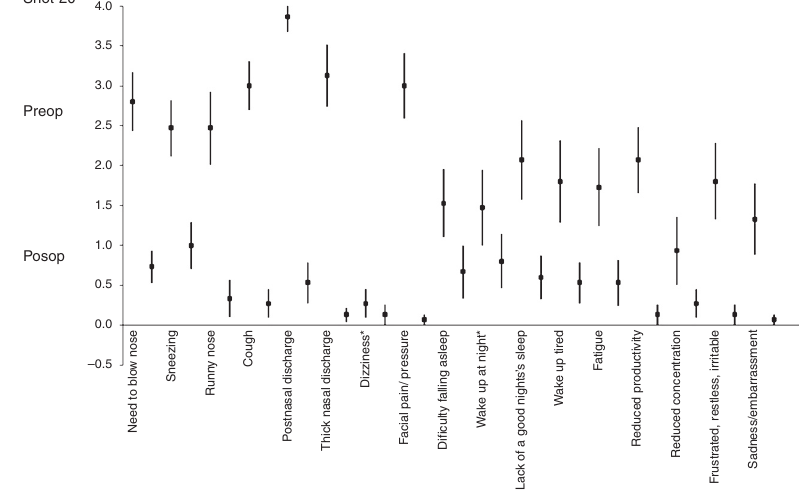
Change in clinical signs of the Sino-Nasal Outcome Questionnaire Test-20 [SNOT-20] from pre- to post-operative period. For all clinical signs, the change from pre- to postoperative had p -value ≤ 0.01, except for those marked with * ( ≥ 0.2). there were substantial benefits. Considering the patient’s perspective, the results justify the therapeutic approach by balloon catheterization.